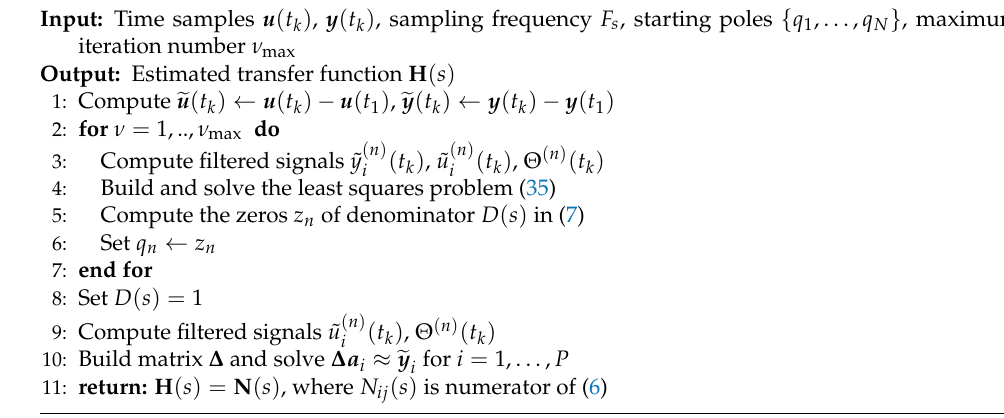
Algorithm 1 The RTVF